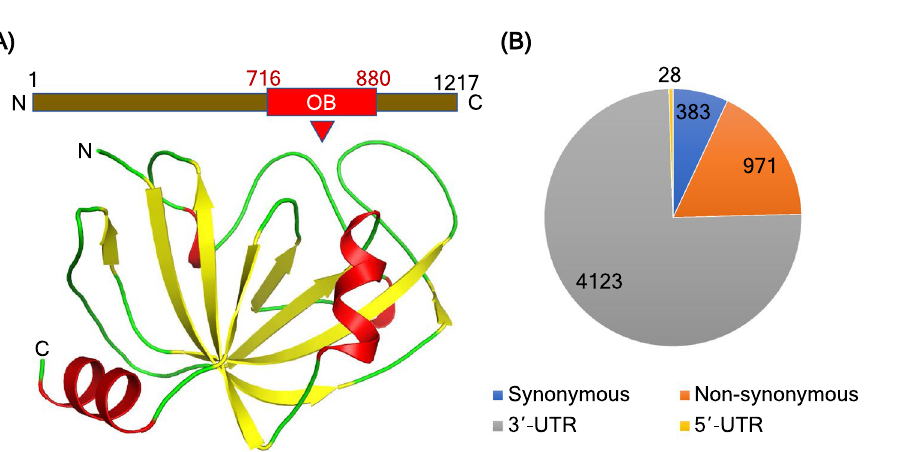
Figure 1. Schematic diagram of the shelterin and CST complexes bound to telomeric DNA. TRF1 telomeric repeat binding factor 1; TRF2 telomeric repeat binding factor 2; TIN2 TRF1 interacting nuclear factor 2; TPP1 protein encoded by adrenocortical dysplasia homolog (ACD) gene; POT1 protection of telomerase; CTC1 conserved telomere maintenance component 1; STN1 suppressor of CDC thirteen homolog; TEN1 telomere length regulation protein TEN1 homolog.